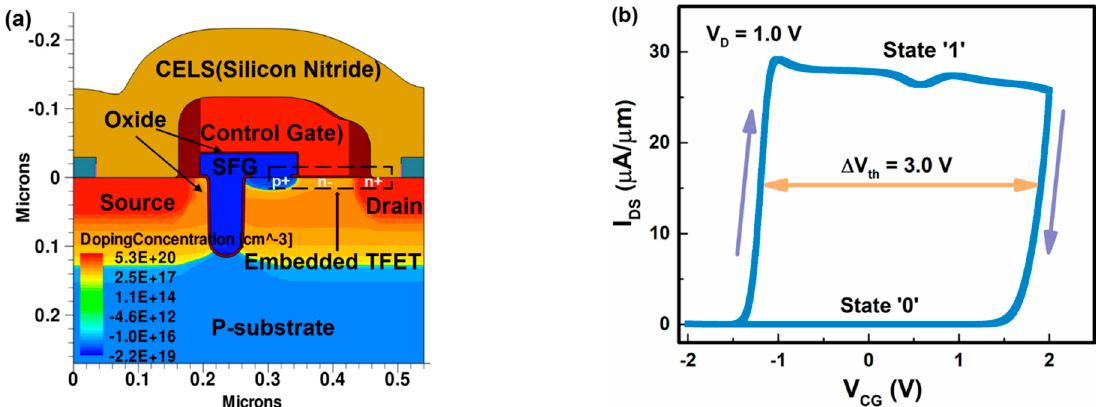
Figure 1. ( a ) Schematic of the U-shaped semi-floating gate transistor (SFGT) structure with tensile Si 3 N 4 capper layer (CELS) and the doping contour used in the simulation; ( b ) The simulated transfer curve of the U-shaped SFGT device. The V th has shifted 3.0 V when the device was switched between state 1 and state 0.